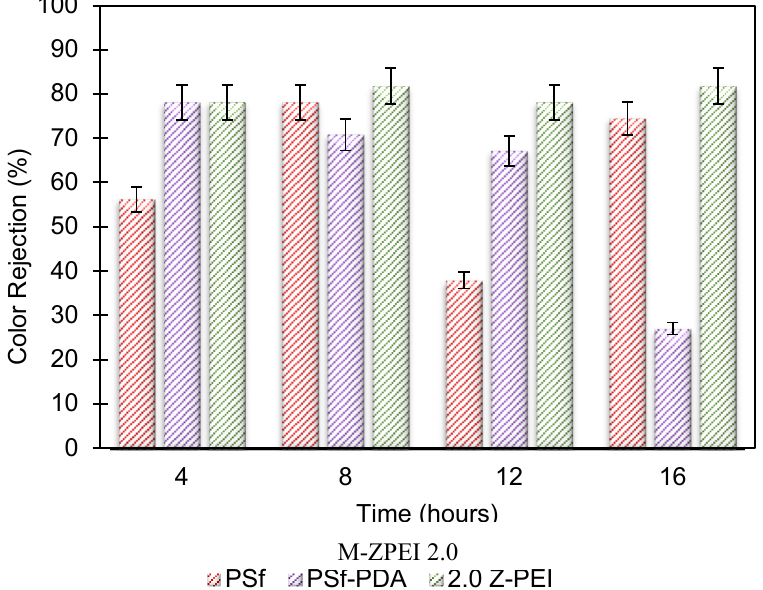
Figure 9. Rejection of coloured POME water by using PSf, PSf-PDA and M-ZPEI 2.0.